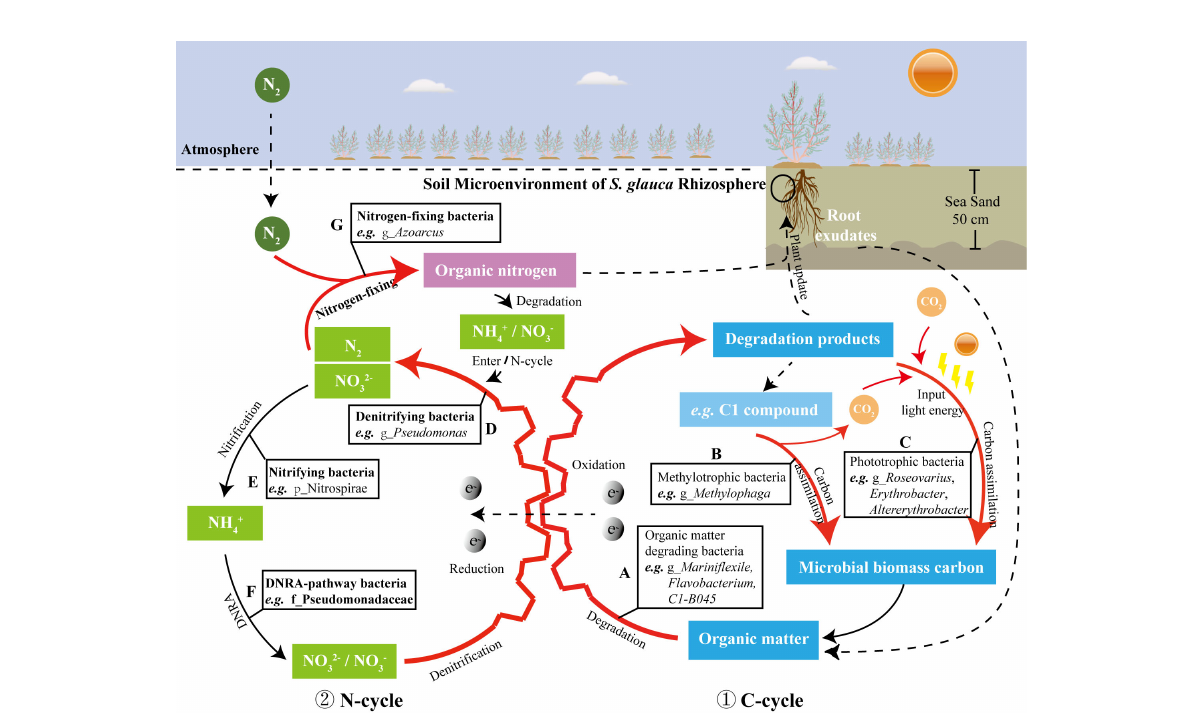
FIGURE 7 The dominant bacterial community in the rhizosphere of S. glauca were predicted to participates in the C/N cycle of TCSS (the red bold lines represent the C/N cycle pathway with enhanced enrichment of the rhizosphere bacterial community of S. glauca ); The serial number ① indicates the predicted C-cycle model; the serial number ② indicates the predicted N-cycle model; the different capital letters in (A – G) refer to the functional bacteria involved in different stages of the C/N cycle,